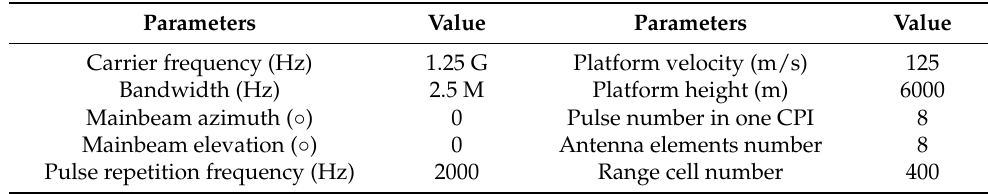
Table 3. Radar System Parameters of Simulated